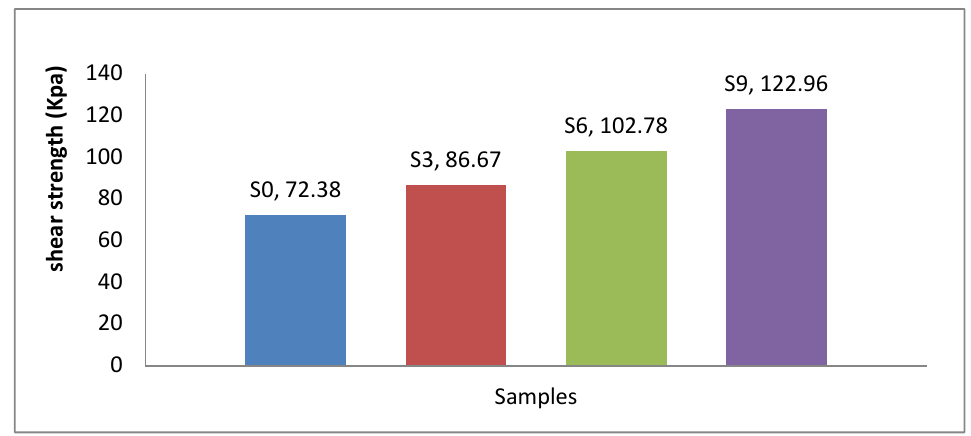
Figure 25. Effects of lime and cement dust on shear strength of swelling soil.